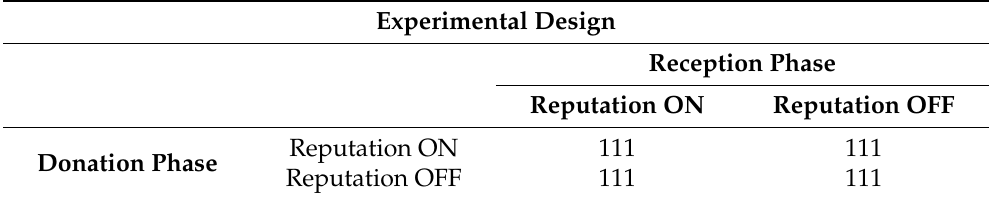
Table 1. Experimental Design. Number of subjects for each